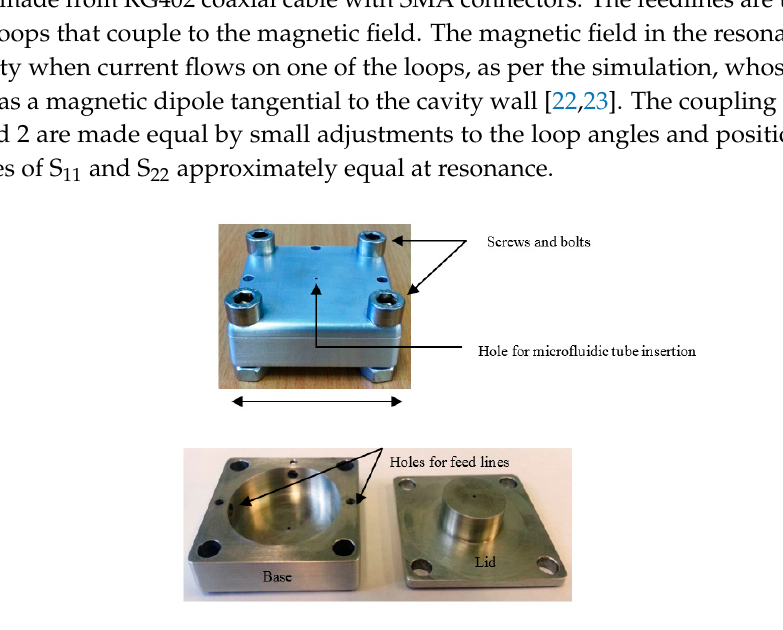
Figure 5. Photograph of the machined re-entrant cavity and its component parts.